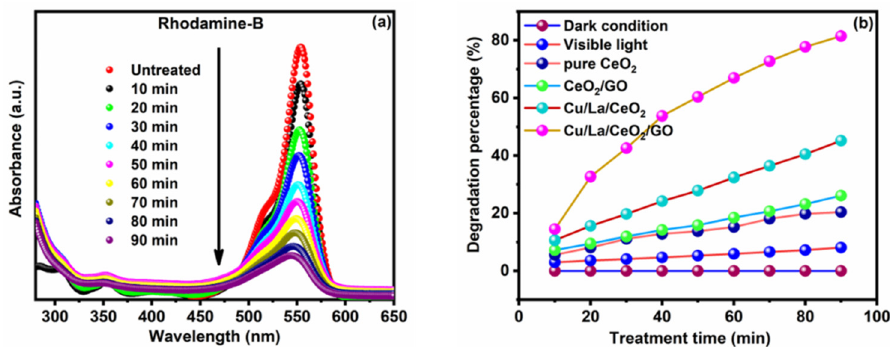
Figure 5. ( a ) Absorption spectrum and degradation percentage of Rhodamine B; ( b ) degradation percentage.